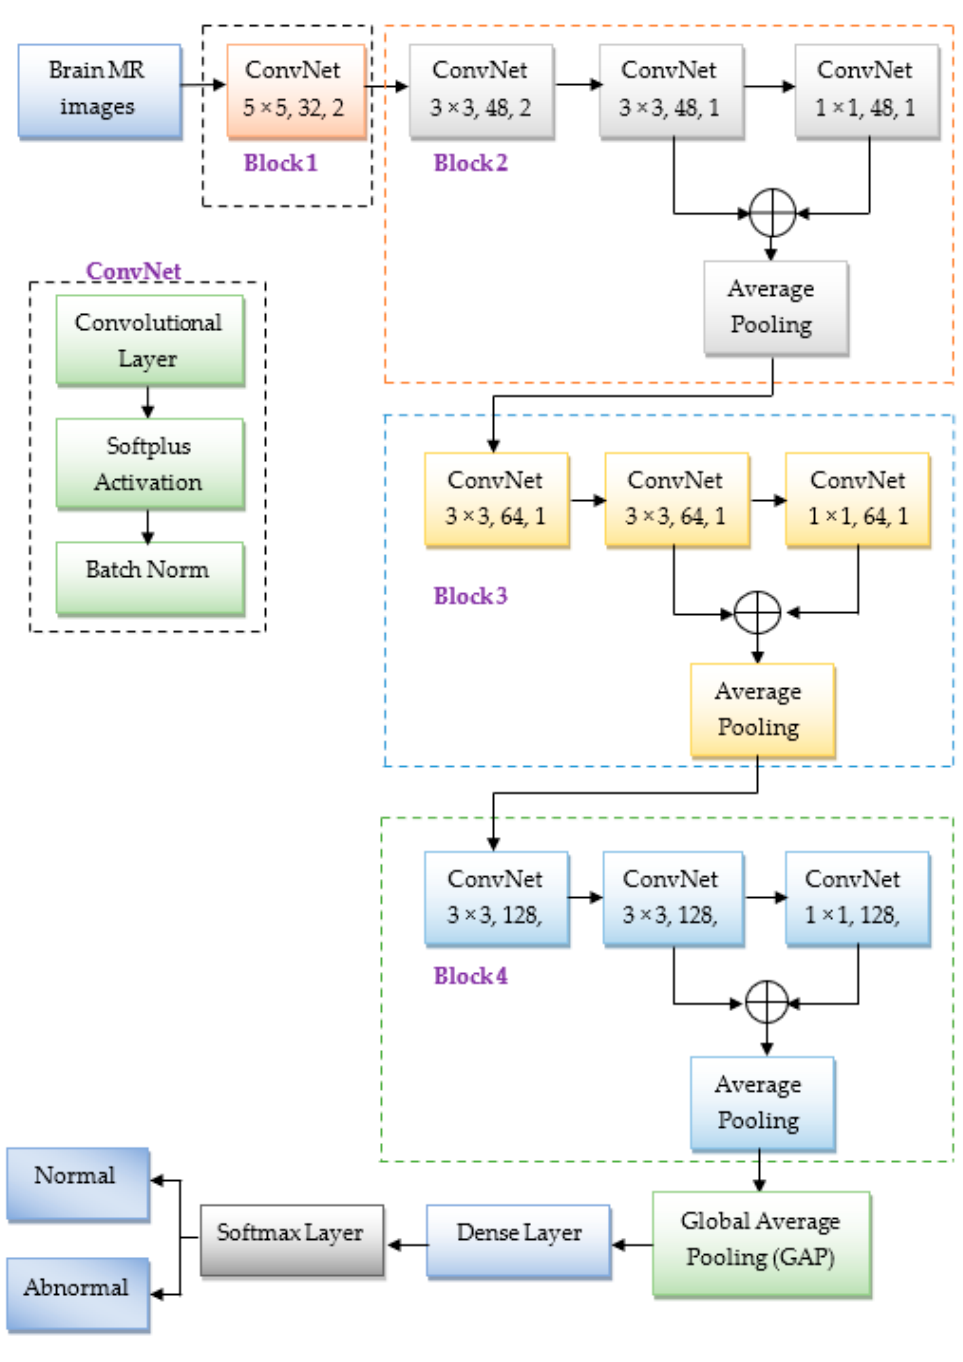
Figure 5. Architecture of the suggested CNN model. Table 3. Configurations of the suggested CNN